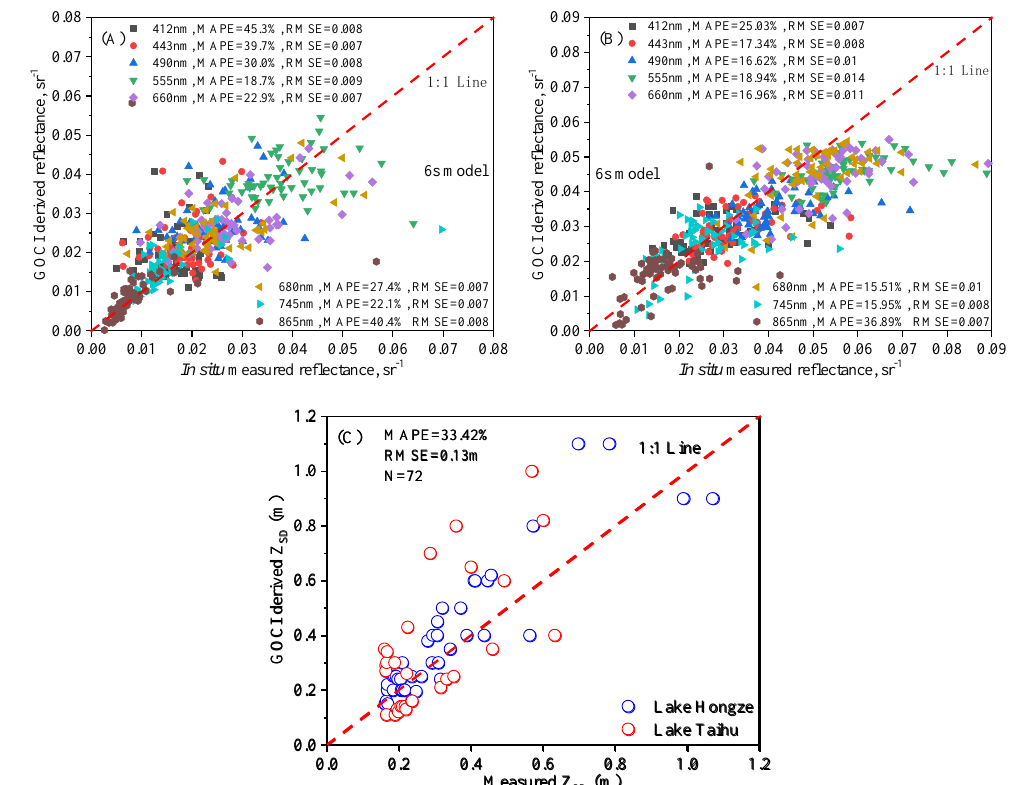
Figure 5. The field measured reflectance corresponded to the Geostationary Ocean Color Imager (GOCI) bands for Lake Taihu ( A ) and Lake Hongze ( B ). The performance of new algorithm based on synchronized images ( C ).